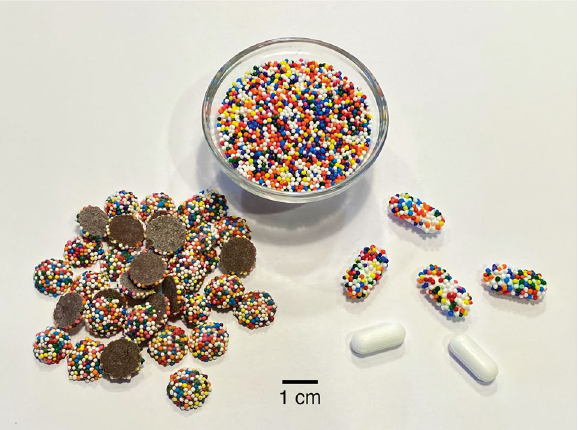
Figure 1. If enough multicolored particles (like these candy “nonpareils,” top) are randomly attached to objects, the odds of two objects having the same pattern of particles are essentially zero. This means that every candy- coated chocolate (left) is likely unique and one-of-a-kind in the entire world. By attaching the same multicolored candies to pharmaceutical products (like the acetaminophen/paracetamol caplets at right), each pill receives